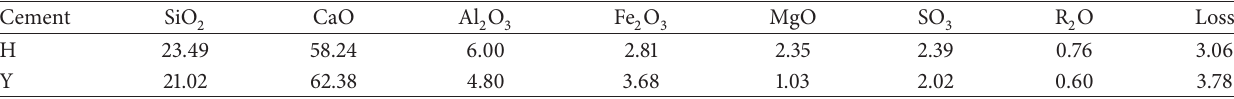
Table 1: Chemical composition of cement (w/%).